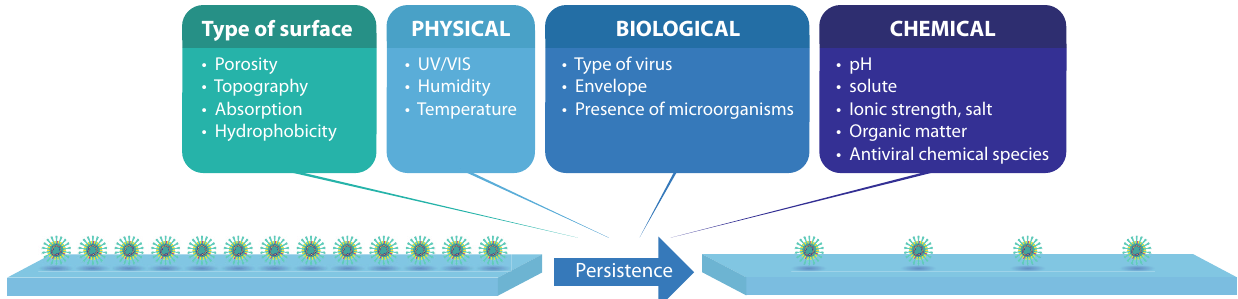
Fig. 2 Surface properties in fl uencing the persistence of viruses. These include physical properties (including light exposure, temperature and humidity), chemical properties (such as pH or antiviral coatings) and biological properties (depending on the virus vulnerabilities, e.g., an envelope) as well as the type of surface such as the porosity